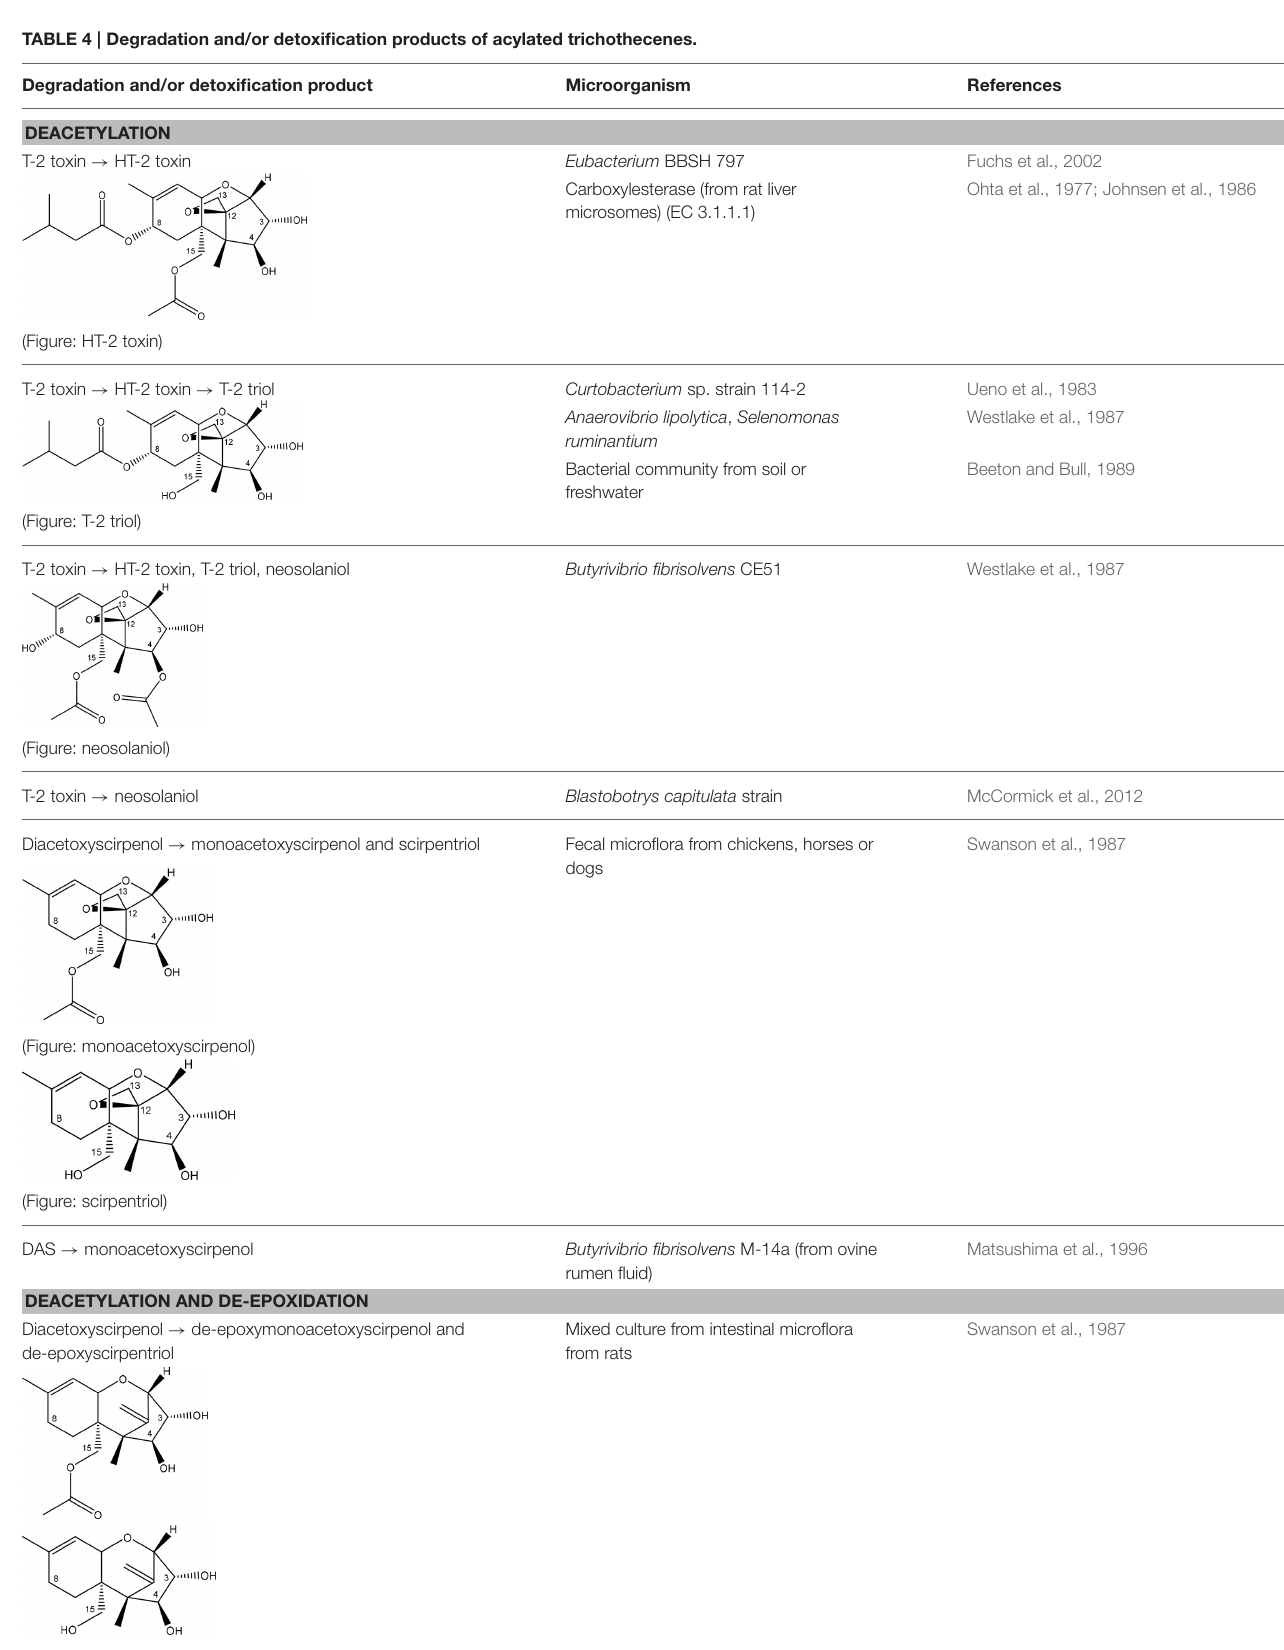
rumen fluid) Mixed culture from intestinal microflora from